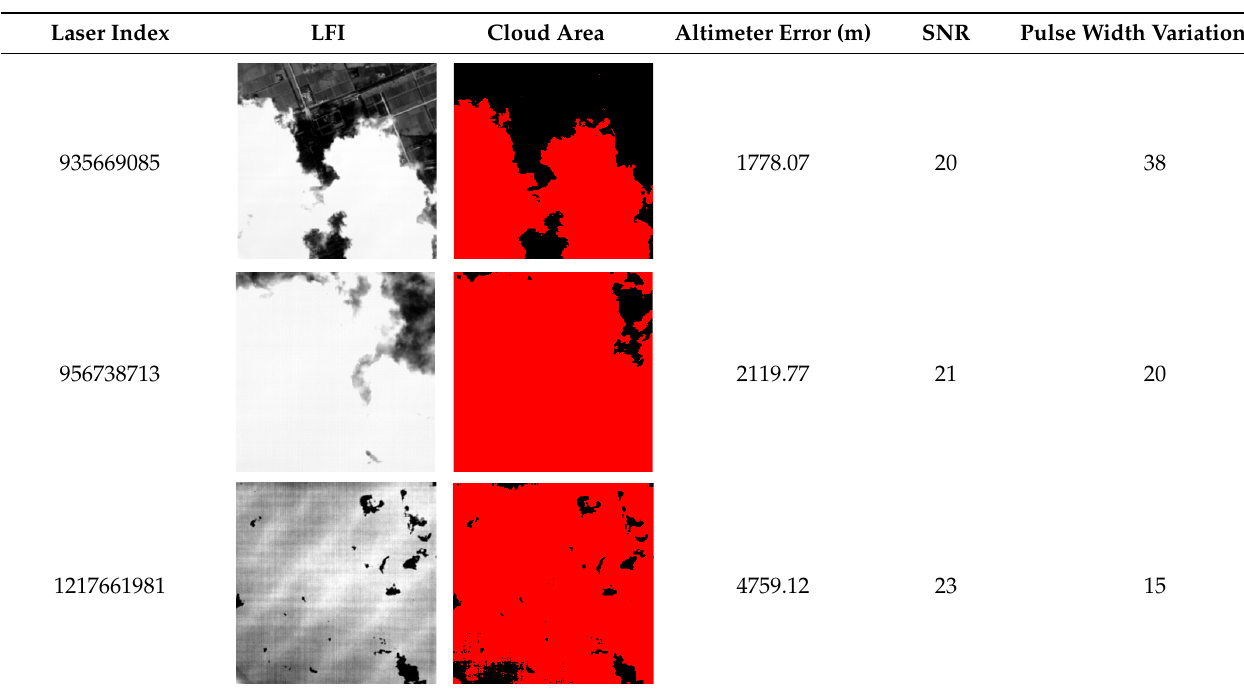
Table 7. Laser points blocked by thick clouds.